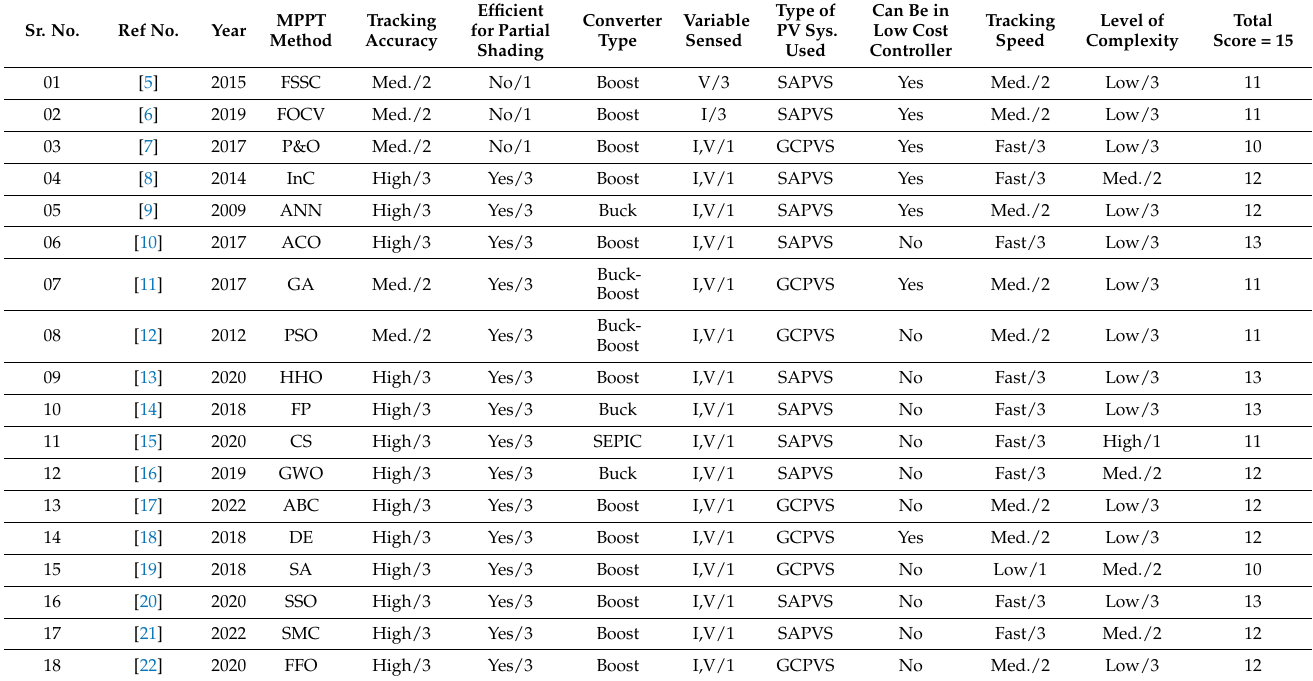
Table 1. Detailed comparison of MPPT